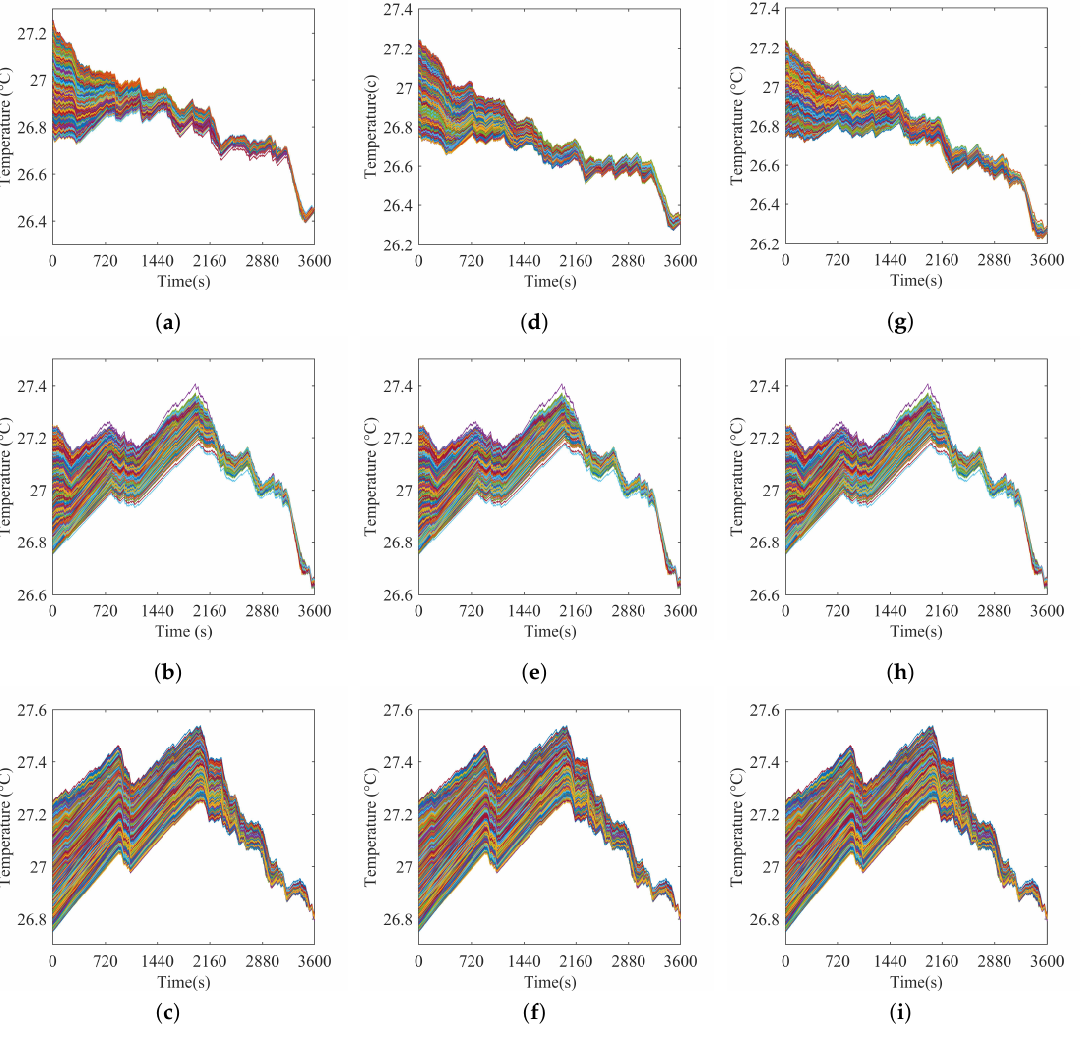
Figure 10. Temperature variation of TCLs in different schemes. ( a ) Temperature variation of TCLs in Scheme A when N = 800. ( b ) Temperature variation of TCLs in Scheme A when N = 1000. ( c ) Temperature variation of TCLs in Scheme A when N = 1200. ( d ) Temperature variation of TCLs in Scheme B when N = 800. ( e ) Temperature variation of TCLs in Scheme B when N = 1000. ( f ) Temperature variation of TCLs in Scheme B when N = 1200. ( g ) Temperature variation of TCLs in Scheme C when N = 800. ( h ) Temperature variation of TCLs in Scheme B when N = 1000. ( i ) Temperature variation of TCLs in Scheme B when N =